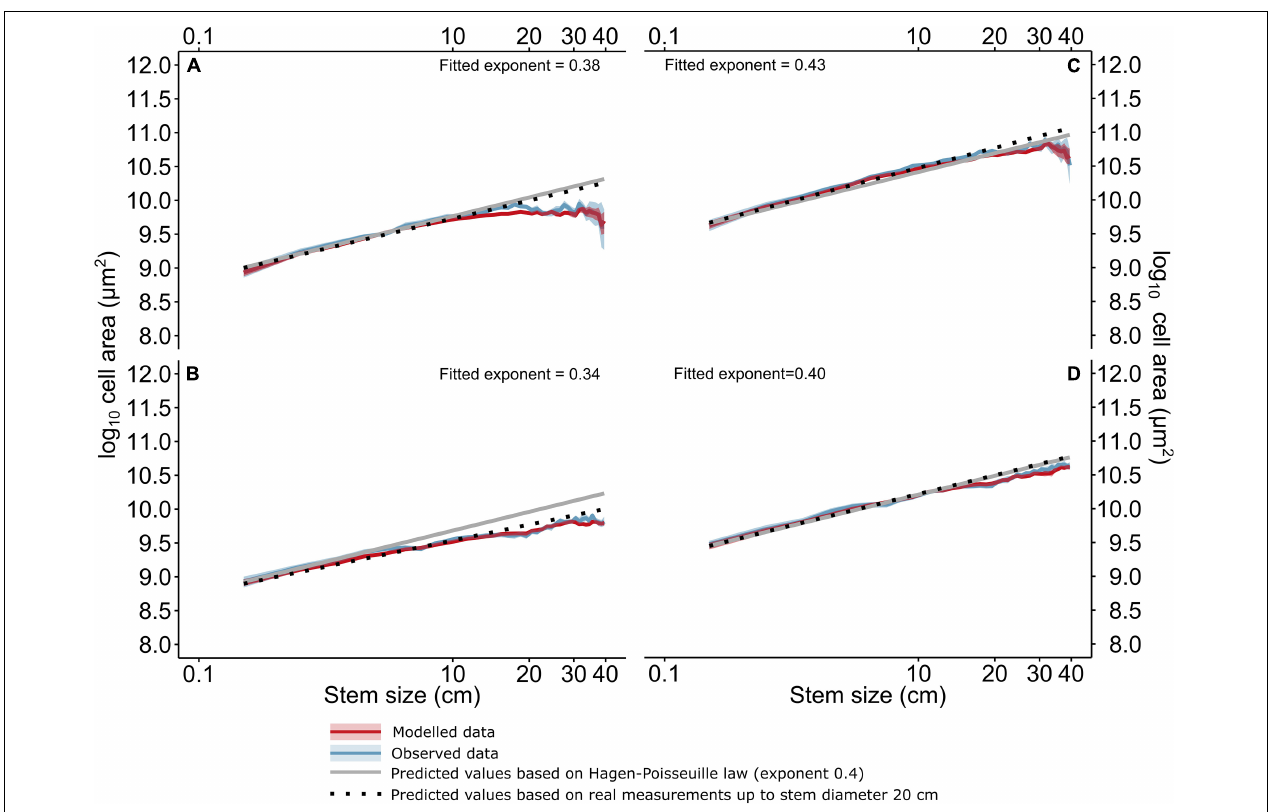
FIGURE 4 | The bootstrapped measured and predicted values of VLA mean (A,C) , VLA 90 (B,D) and differences from the expected values based on a linear regression of log-log transformed measured data. The solid black lines represent predicted values based on the Hagen-Poisseuille law, the dotted black lines show predicted values based on real measurements up to the stem diameter 20 cm. The solid red lines represent values predicted by the linear mixed effect models, and the solid blue lines represent measured values, respectively, their difference from predicted values based on the Hagen-Poisseuille law. CI s represent the bootstrapped means ( p = 0.95) of both observed and modeled data for stem size intervals of 1